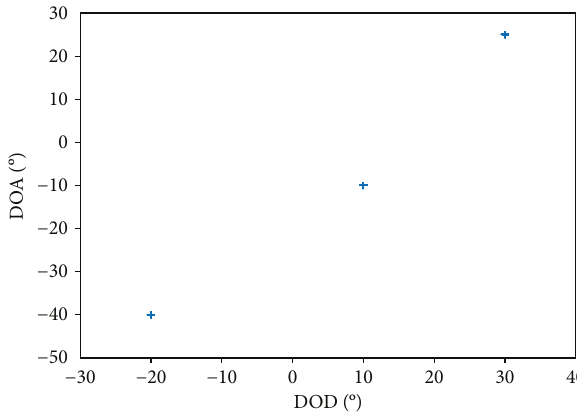
Figure 1: 100 realizations of the proposed method. SNR